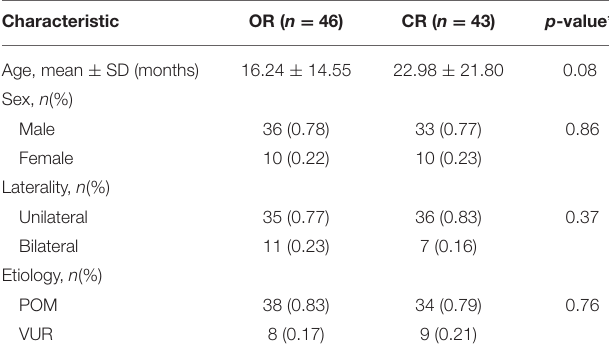
TABLE 1 | Comparison of patient characteristics between modified ureteral orthotopic reimplantation (OR) and Cohen reimplantation (CR).